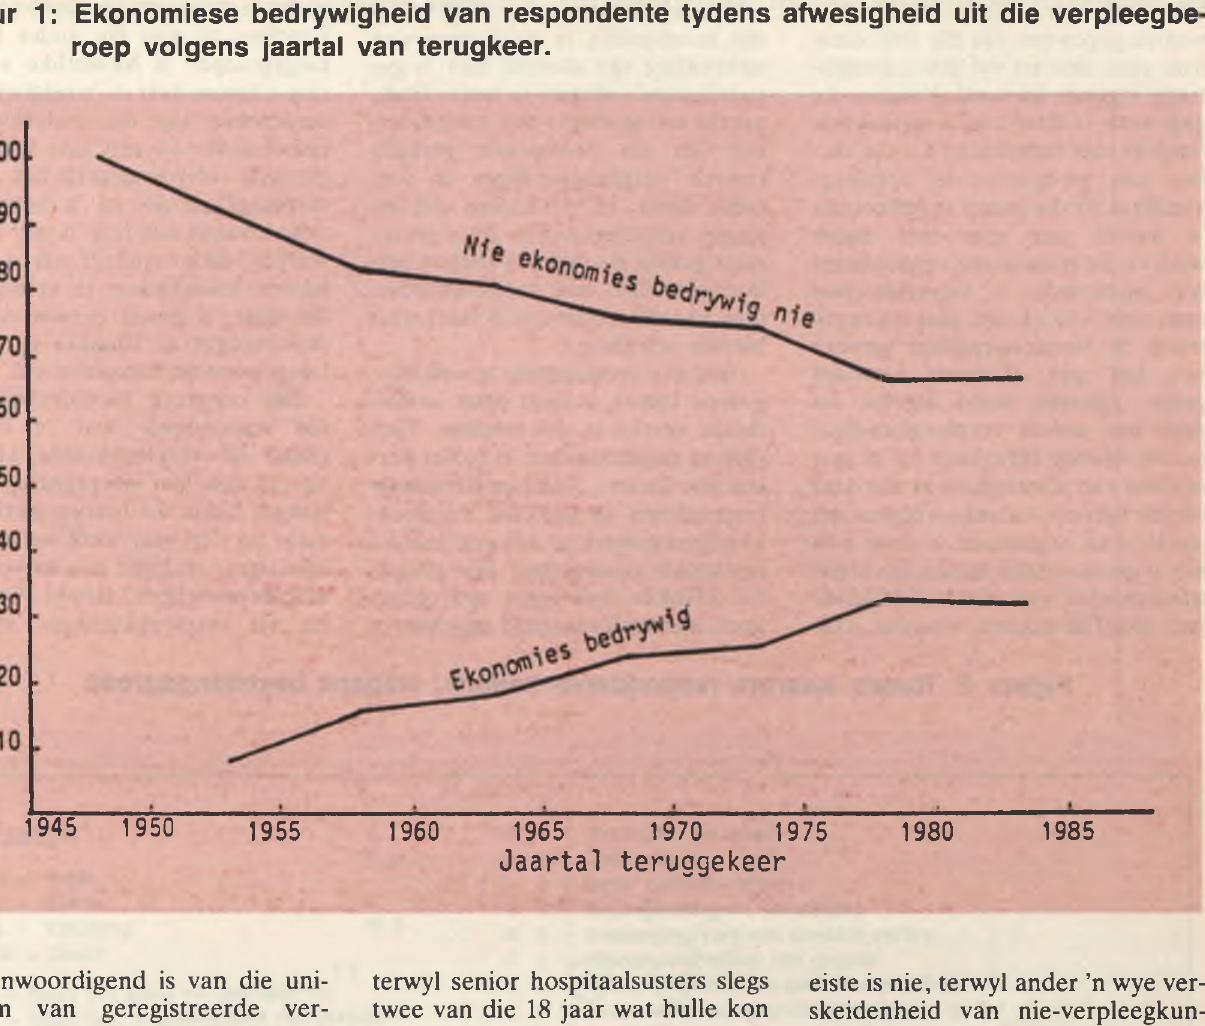
Figuur 1: Ekonomiese bedrywigheid van respondente tydens afwesigheid uit die verpleegbe roep volgens jaartal van